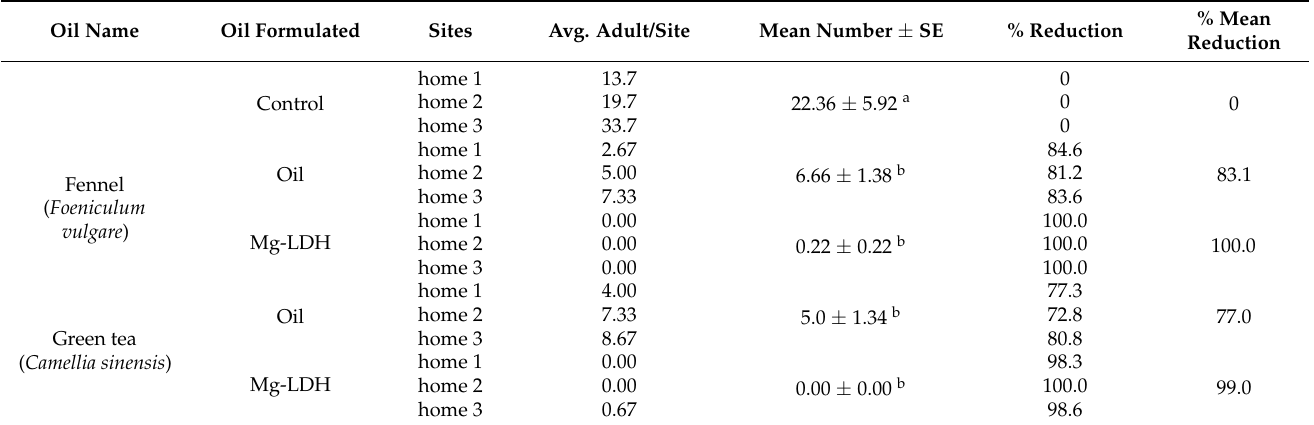
Table 7. Field evaluation of the applied materials against adult mosquito in different homes, 24 post- treatment.